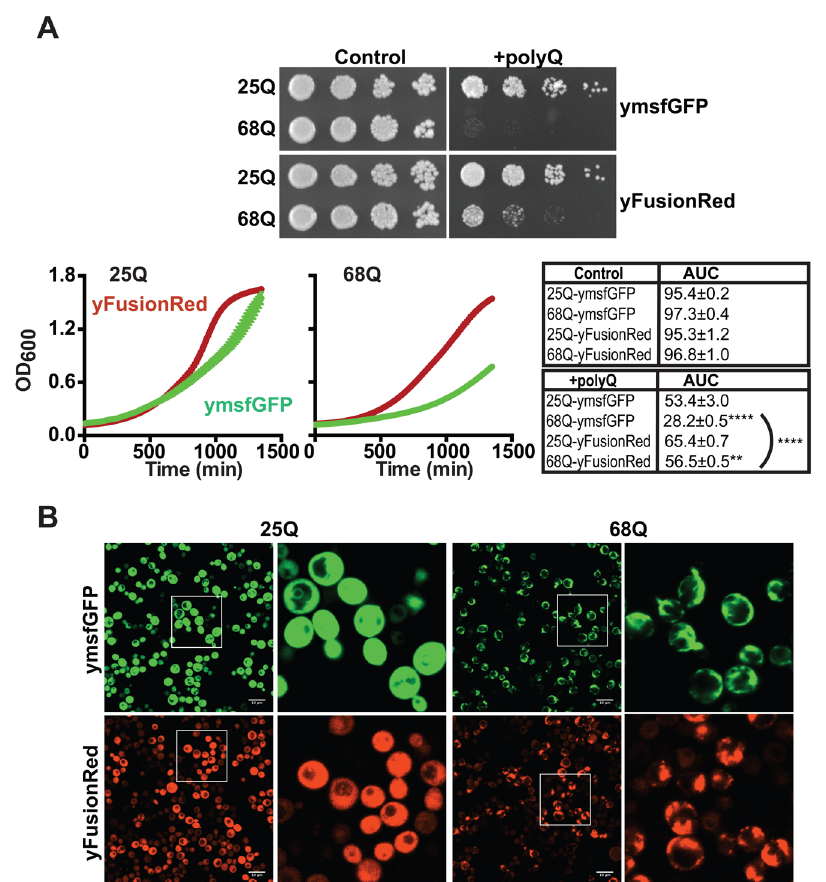
Figure 4. Expanded Htt ex1 -yFusionRed is toxic when expressed at high levels. ( A ) Images of yeast growth assays on agar plates. Yeast cells carrying 25/68Q Htt ex1 fused to either ymsfGFP or yFusionRed in a 2µ multicopy vector were grown to saturation overnight in glucose (control). The next days, cell concentrations were equalized to OD 0.2 and 5 fold serial dilutions of the cell suspension spotted on synthetic 600 complete agar media plates containing either glucose (control) or galactose (+polyQ). Alternatively, cells were cultured in liquid media and optical densities were recorded over time to generate growth curves. The area under the curve (AUC) was calculated from 3 experimental replicates. **p<0.01 and ****p<0.0001 according to a one way ANOVA followed by a Tuckey’s multiple comparison test comparing the 68Q sample to its 25Q counterpart unless indicated otherwise. ( B ) Representative fluorescent images from 3 fields of yeast cells expressing 25/68Q Htt Htt ex1 fused to ymsfGFP or yFusionRed from a multicopy 2µ vector after overnight induction in galactose-containing media. Under these conditions, 68Q-yFusionRed displays robust aggregation.